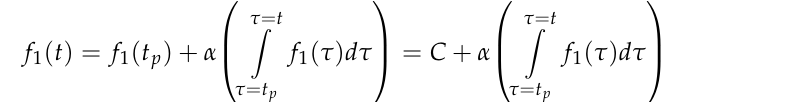
Figure 4. Voltage curves used for the determination of the waveform parameters in the proposed method.